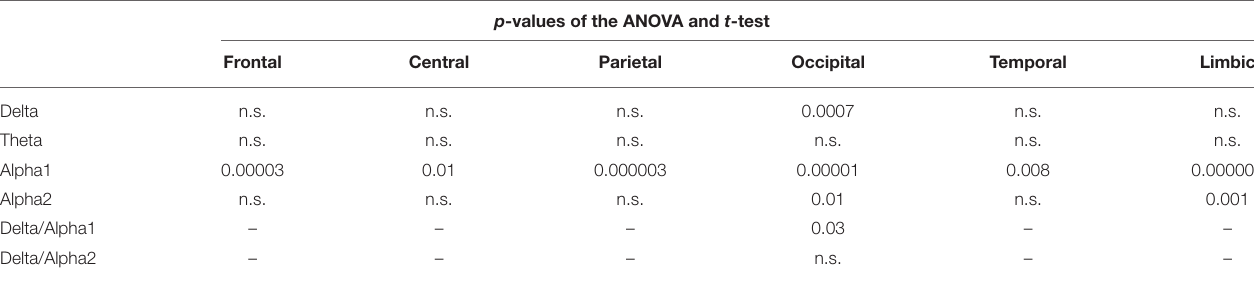
TABLE 4 | p -values (Duncan post-hoc ) of the ANOVA related to the comparisons of inter-hemispherical lagged linear connectivity showing a statistically significant interaction [ F (30 , 6540) = 4.8771, p < 0.0001] among the factors Group (AD, Nold), ROI pairs (frontal left-frontal right, central left-central right, parietal left-parietal right, occipital left-occipital right, temporal left-temporal right, limbic left-limbic right), and Band (delta, theta, alpha 1, alpha 2, beta 1, beta 2, gamma) and p -values of the t -tests for each composite EEG marker. p -values of the ANOVA and t -test